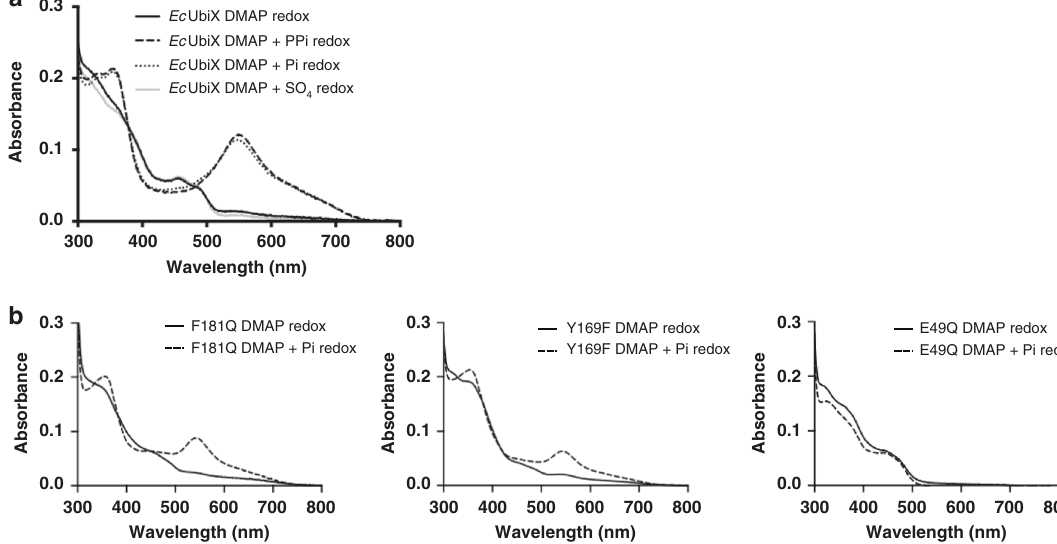
Fig. 5 Phosphate salvages prFMN formation with DMAP in DMAPP-speci fi c UbiX. a UV – Vis spectra following oxidation of FMNH 2 : Ec UbiX incubated with DMAP and 5 mM pyrophosphate, phosphate or sulphate to the reduced reaction. Only the addition of either phosphate and pyrophosphate salvages prFMNH 2 production as indicated by purple prFMN semiquinone formation. b UV – Vis spectra following oxidation of FMNH 2 :F181Q, Y169F and E49Q Pa UbiX variants with and without the addition of 5 mM phosphate to the reduced reaction. Both F181Q and Y169F variants form prFMNH is added, while E49Q remains unaffected by phosphate addition and unable to yield the